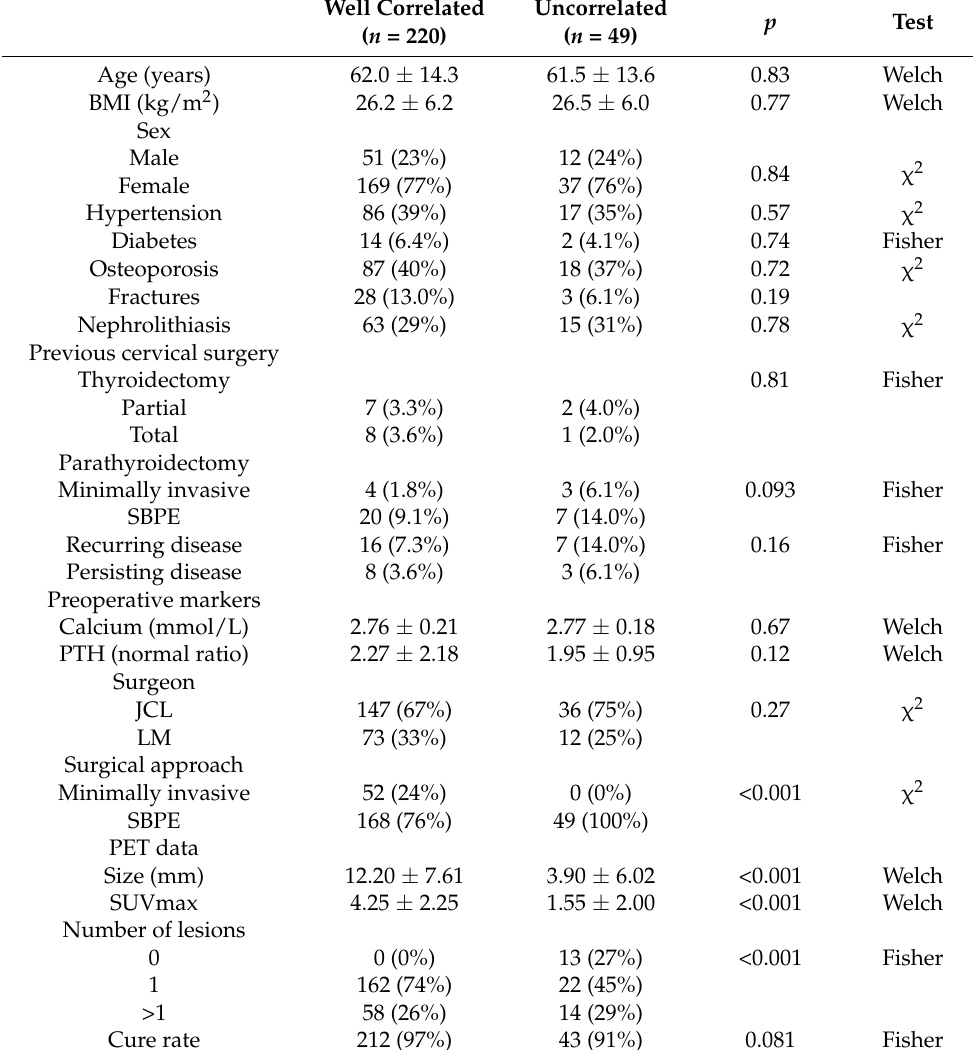
Table 3. Correlation between 18 F-choline positron emission tomography/contrast-enhanced com- puted tomography and surgical